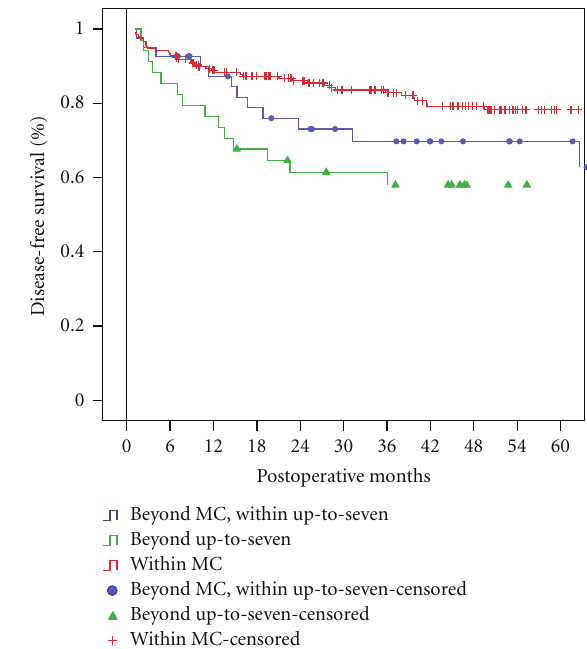
Figure 1: Disease-free survival of patients within preoperative MC ( n = 224), beyond preoperative MC but within up-to-seven criteria ( n = 43), and beyond preoperative up-to seven criteria ( n = 16) ( P = . 8).